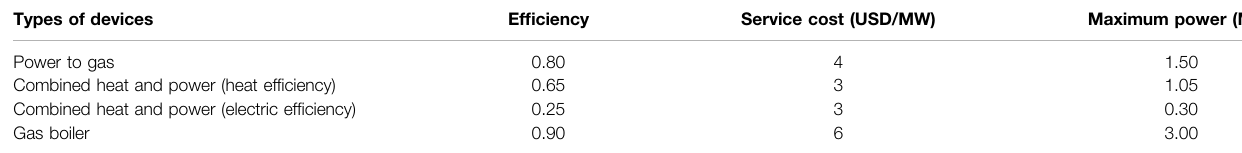
TABLE 3 | Device parameters.